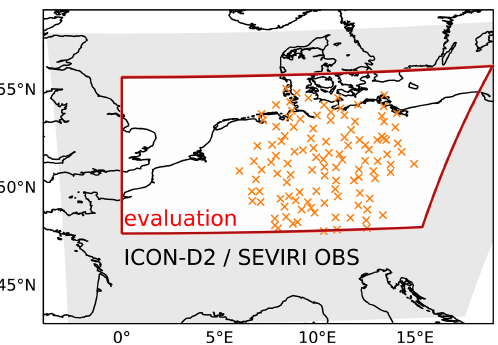
Figure 1. ICON-D2 domain in the observation space (grey shading) and the reduced evaluation domain (red box). The orange x sym- bols indicate the DWD pyranometer stations that measure global horizontal